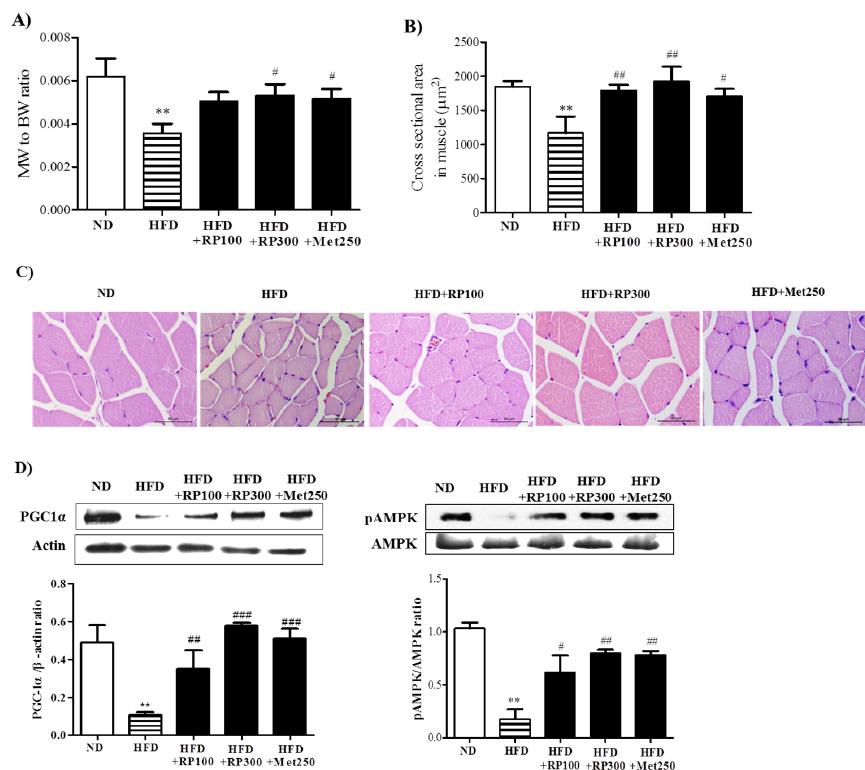
Figure 5. Effect of RP extract on skeletal muscle atrophy and energy metabolism. ( A ) Muscle (gastrocnemius) to body weight ratios; ( B ) Cross sectional areas of gastrocnemius muscle fibers; ( C ) Muscle fiber morphologies, original magnification 400 × ; ( D ) PGC-1 α and pAMPK protein levels in skeletal muscle tissues. Results are presented as means ± standard errors of the mean (SEM) ( n = 5). ** p < 0.01 vs. the normal chow fed controls (ND group); ### p < 0.001, ## p < 0.01 and # p < 0.05 vs. the HFD mice. RP, Radix Pueraria lobata ; BW, body weight; MW, muscle weight; ND, normal diet; HFD, high fat diet; PGC-1 α , peroxisome proliferator-activated receptor gamma coactivator-1 alpha; AMPK, adenosine monophosphate-activated protein kinase.